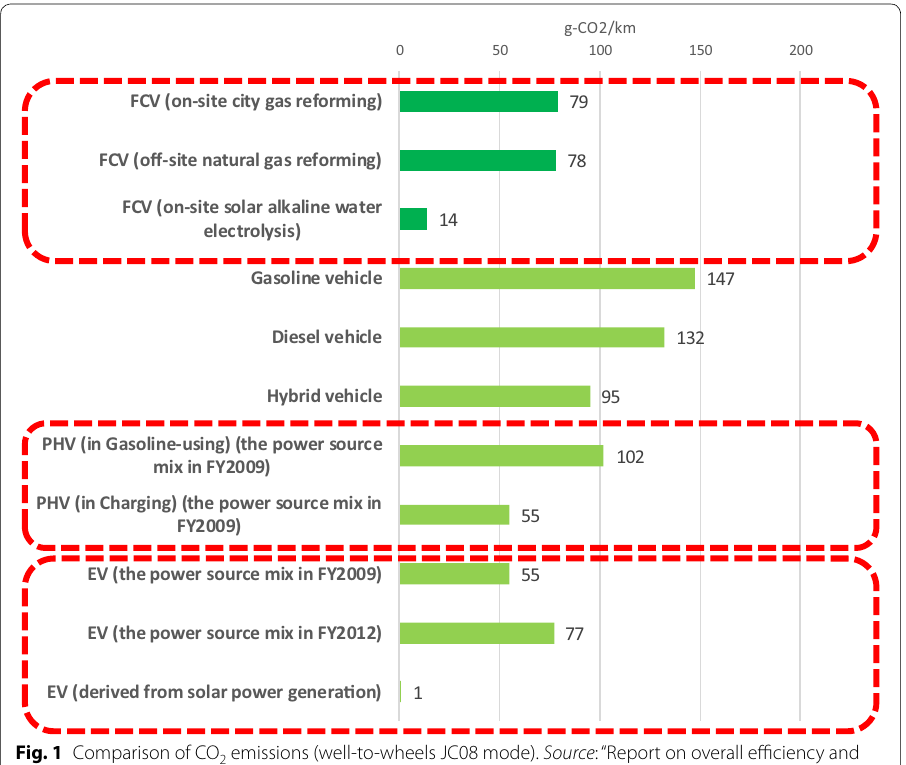
Fig. 1 Comparison of CO 2 emissions (well-to-wheels JC08 mode). Source : “Report on overall efficiency and GHG emissions by type of vehicles,” Japan Automobile Research Institute, March, 2011. “The roadmap of the hydrogen and fuel cell strategy, Revised,” Hydrogen and fuel cell council, METI, March, 2016. Note The CO 2 emission of EV (the power source mix in FY2012) is estimated suitable to the power source mix in FY2012 by the Hydrogen and fuel cell council,